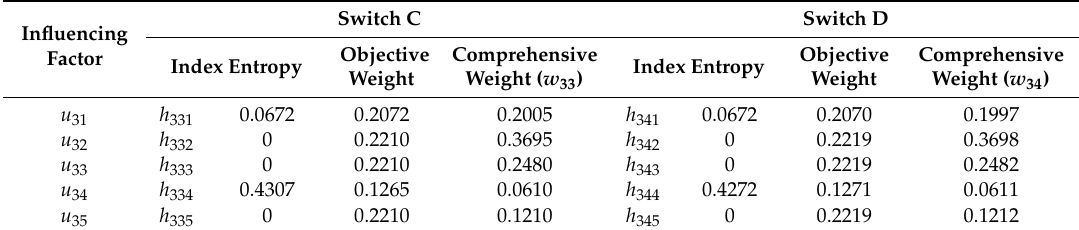
Table 19. The objective and comprehensive weights of the influencing factors of Switch C and Switch D.